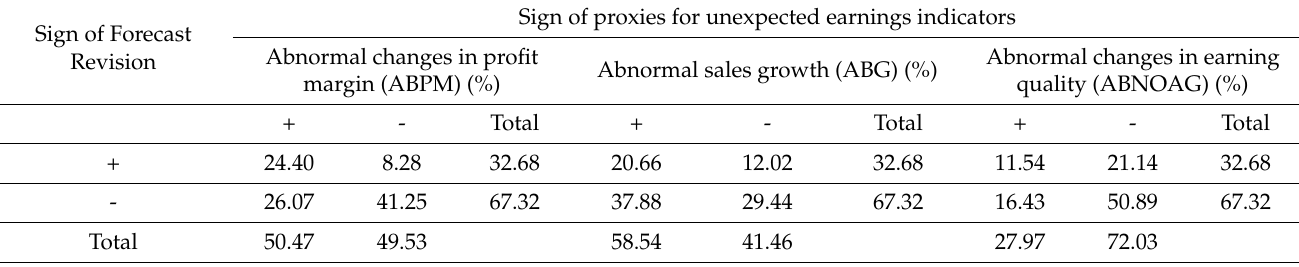
Table 7. Contingent Analysis c . Panel A: Contingent table of the signs of the forecastrRevision vs. unexpected earnings predictors, a shown as the percentage out of the total sample observations.